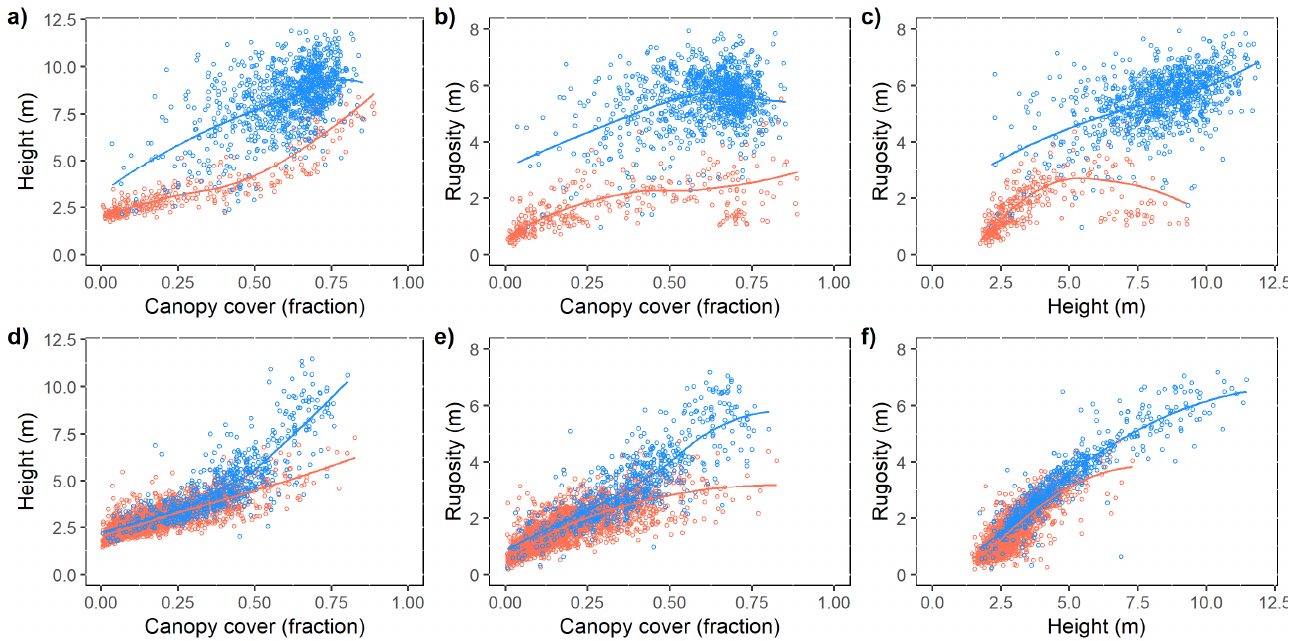
Figure 2. Relationships of different canopy metrics in deciduous and evergreen forests. Different colors indicate tree locations (blue in southern aspects and orange in northern aspects). The LOWESS smoothers indicated by blue and orange lines are for southern and northern aspects, respectively. Sub-plot ( a – c ) are for deciduous forests, while sub-plot ( d – f ) are for evergreen forests.